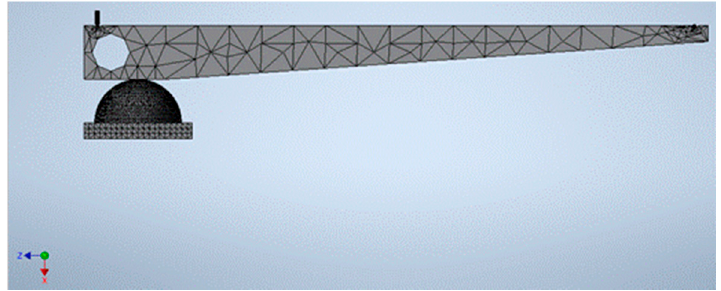
Figure 8. The mesh of finite elements.